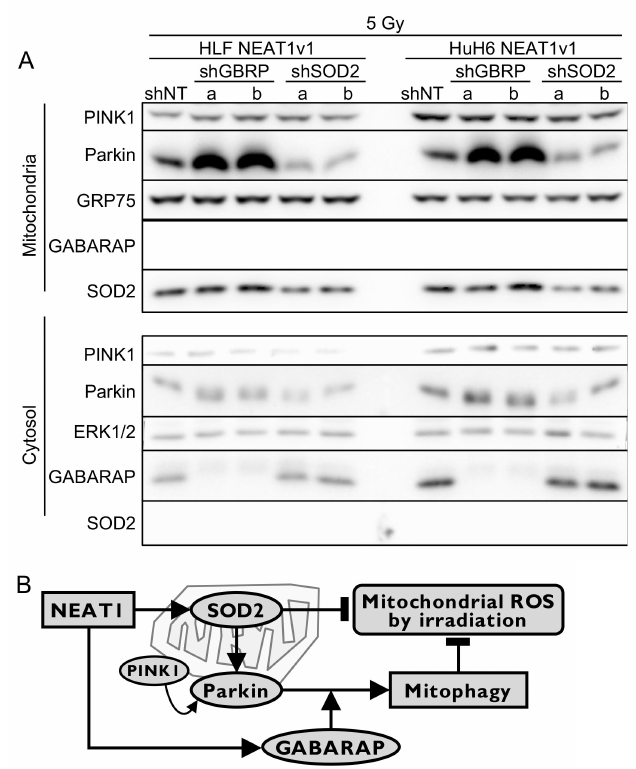
Figure 5. Involvement of GABARAP and SOD2 in NEAT1v1-induced mitophagy. ( A ) Representa- tive Western blot images for mitochondrial and cytosolic PINK1, parkin, SOD2, GABARAP, GRP75 (mitochondrial marker), and ERK1/2 (cytosolic marker). C, CTRL, control cells; NEAT, NEAT1v1- overexpressing cells. ( B ) Schematic representation of NEAT1v1-induced radioresistance via the PINK1/parkin-mediated mitophagy. NEAT1v1 upregulates GABARAP and SOD2 in HCC cells. GABARAP is a critical factor for mitophagy, whereas SOD2 reduces oxidative stress by its antioxida- tive activity and induces parkin